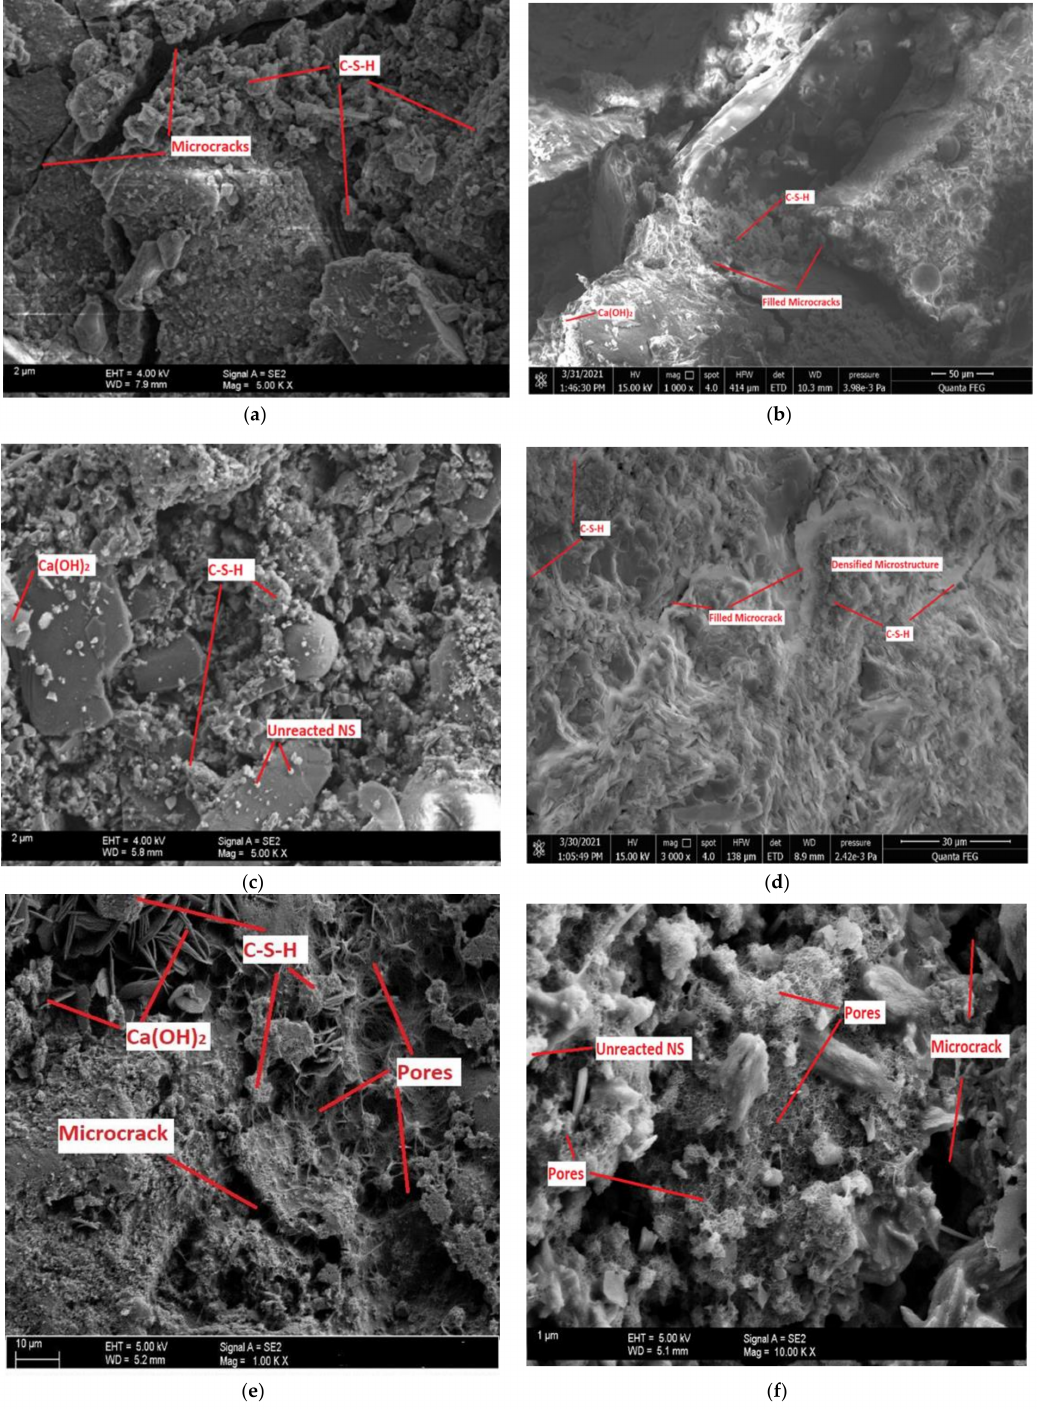
Figure 16. FESEM Microstructural Morphology. ( a ) Control Mix (M0C0N). ( b ) M7.5C2N. ( c ) M15C1N. ( d ) M15C2N. ( e ) M22.5C0N. ( f )